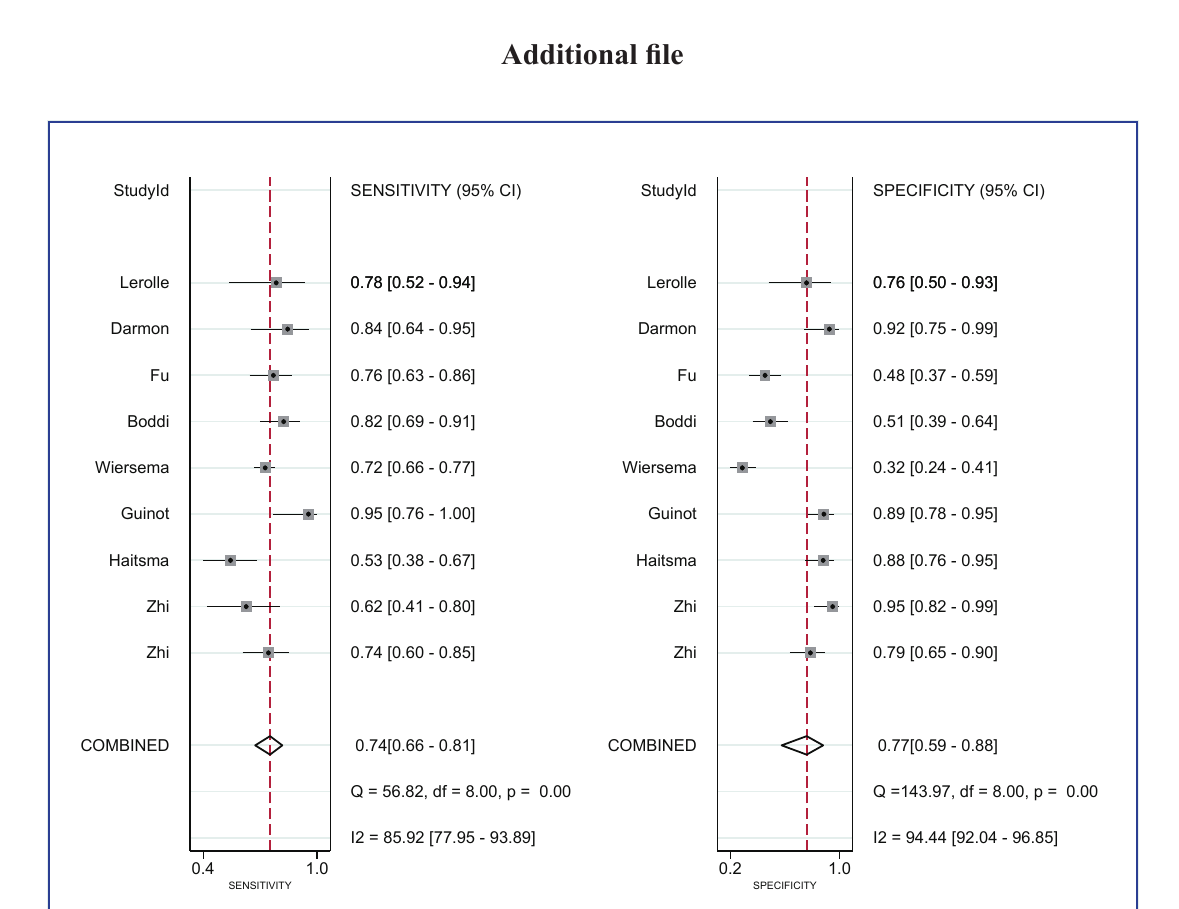
Study Regression Line